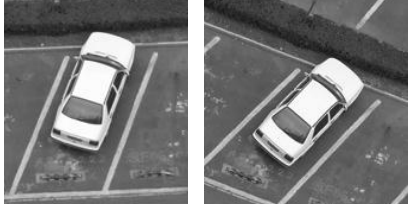
Figure 2(b) parts of stereo-images from camera hanged on the ballon. This stereo-image has large rotation angle which approximately equals 80 degree. The size of left image is 353 pixel  391 pixel, and the image size of right image is 401pixel  321pixel.